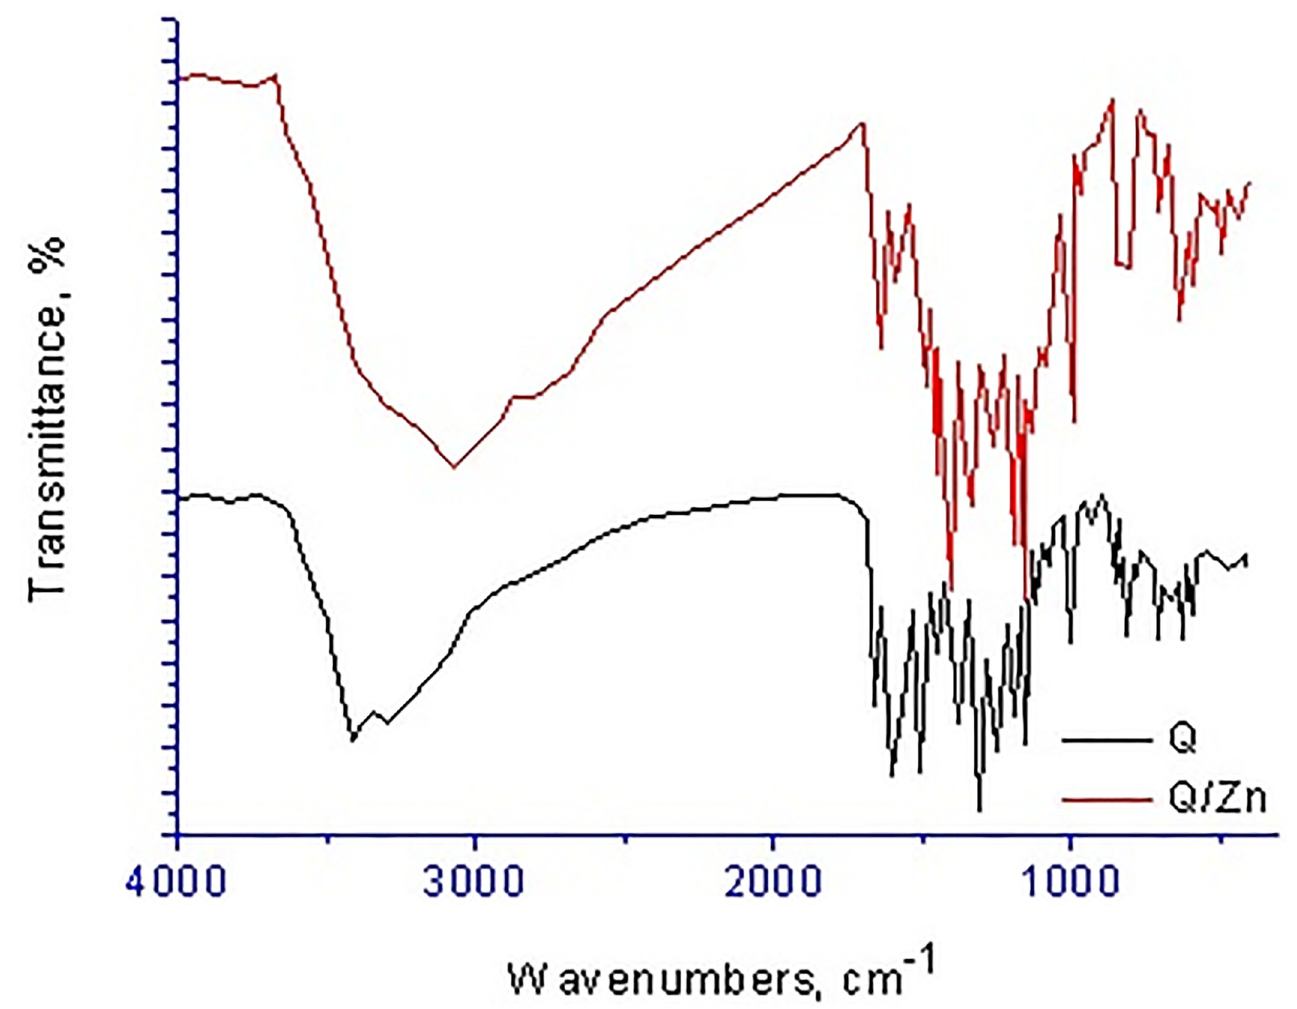
Fig 3. Infrared spectra of free Q ligand and its zinc(II) complex.